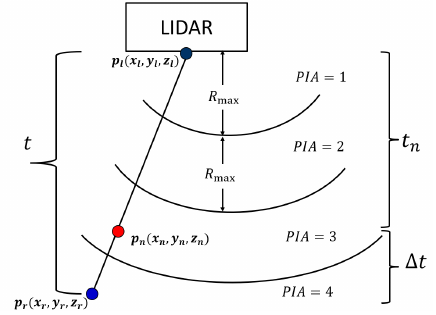
Figure 3: Parametric Generative Model